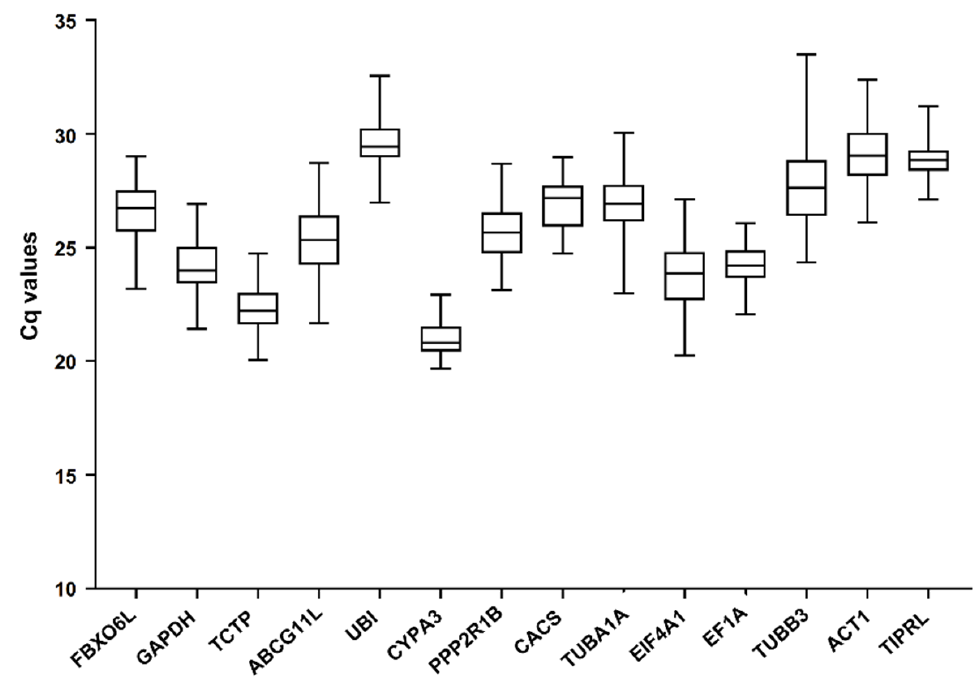
Figure 1. The Cq values for 14 candidate reference genes in all samples.